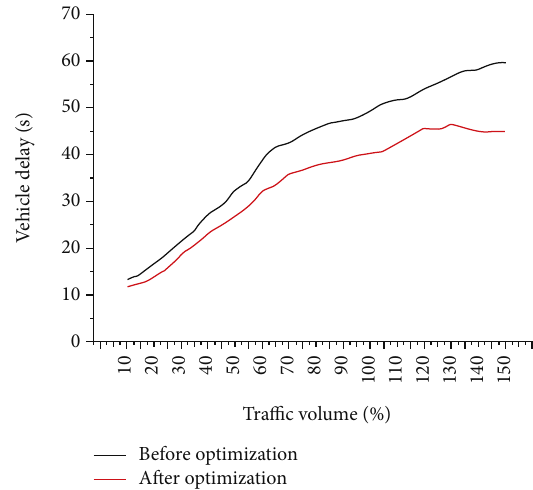
Figure 7: The impact of tra ffi c volume on average vehicle delay.